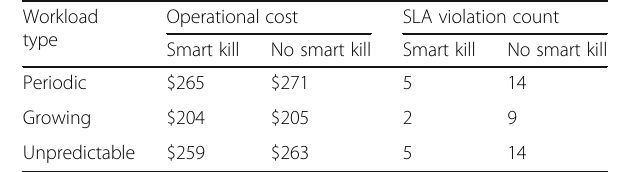
Table 5 The impact of the smart kill on the cost